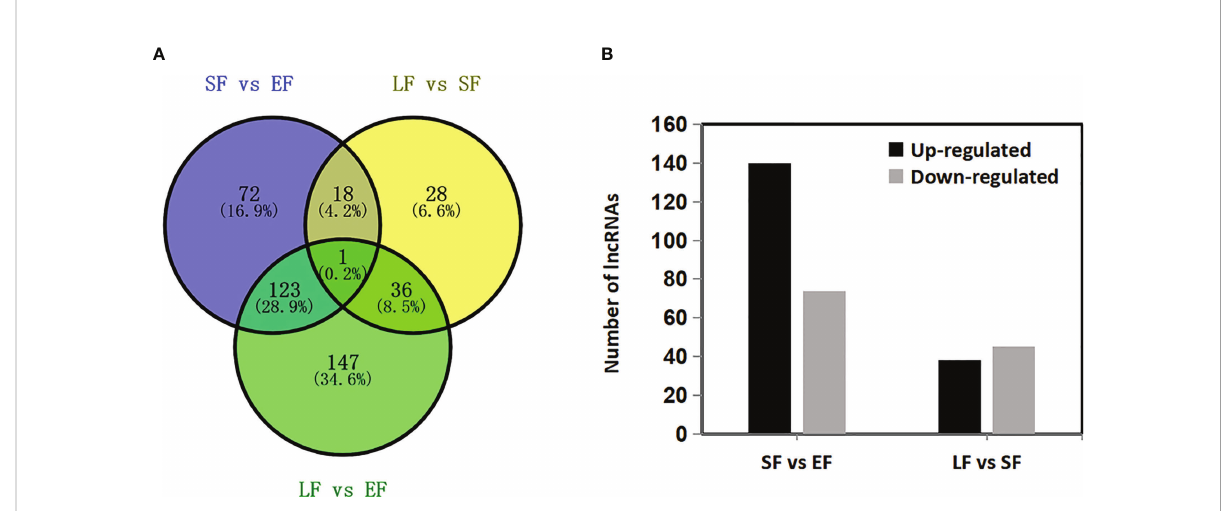
FIGURE 6 Differentially expressed lncRNAs in fl ower developmental stages in rose ‘ Tianmidemeng ’ . (A) Venn diagram of differentially expressed lncRNAs when comparing successive fl ower developmental stages from early fl owering (EF), semi- fl owering (SF), to late fl owering (LF). (B) Graphic presentation of up- and down-regulated differentially expressed lncRNAs when comparing successive fl ower developmental